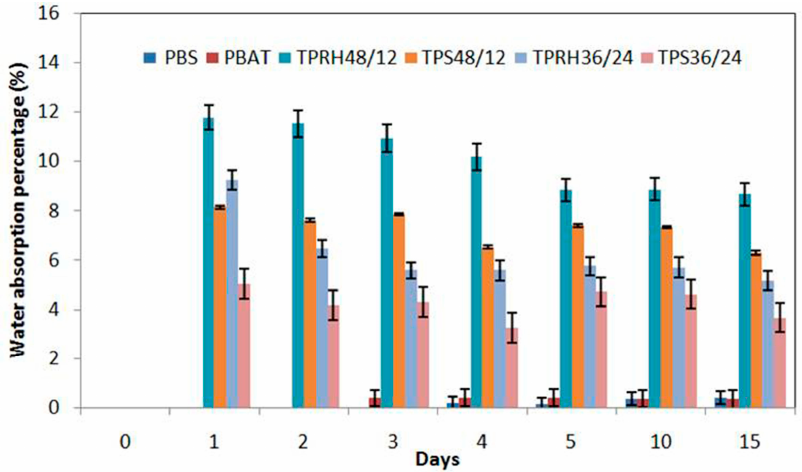
Figure 7. Water absorption of bare PBS, bare PBAT, and PBS/PBAT blends with immersion times. The PBS/PBAT/TPRH composites showed a larger water absorption capacity than